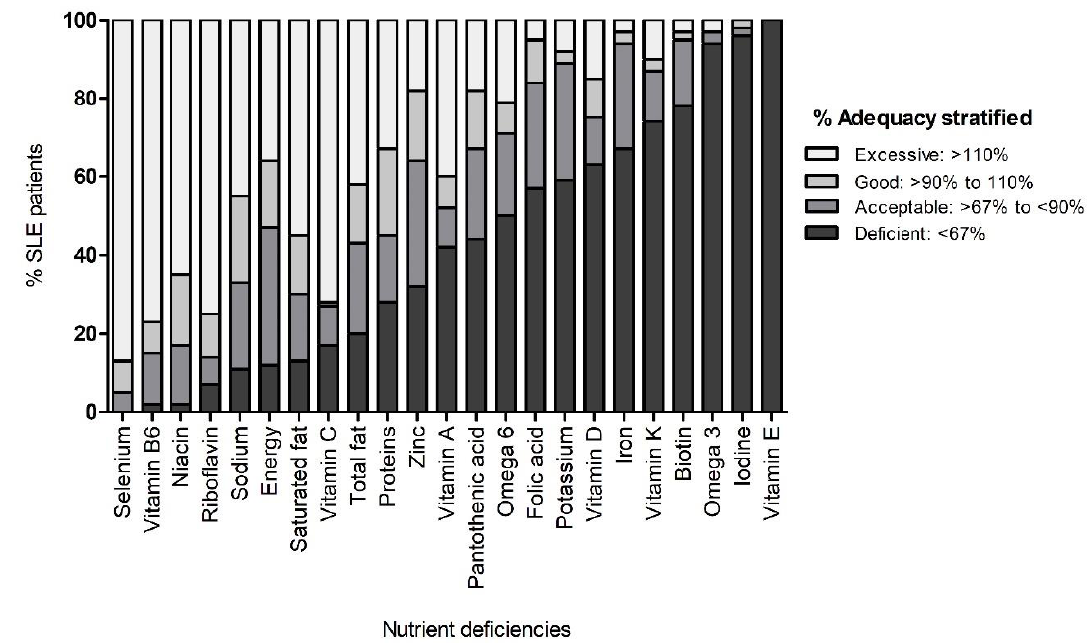
Figure 1. Intake of systemic lupus erythematosus patients according to their most common nutrient deficiencies. Data provided in percentages.